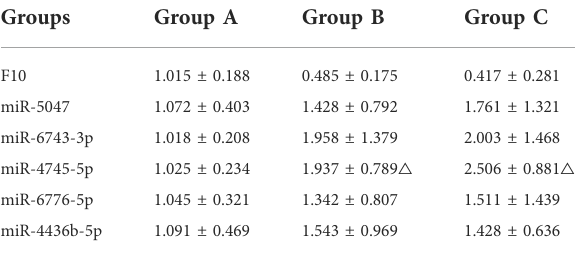
TABLE 8 Expression levels of FX miRNA gene and corresponding miRNA in PBMC of patients ( (cid:1) x ± s , n = 10).